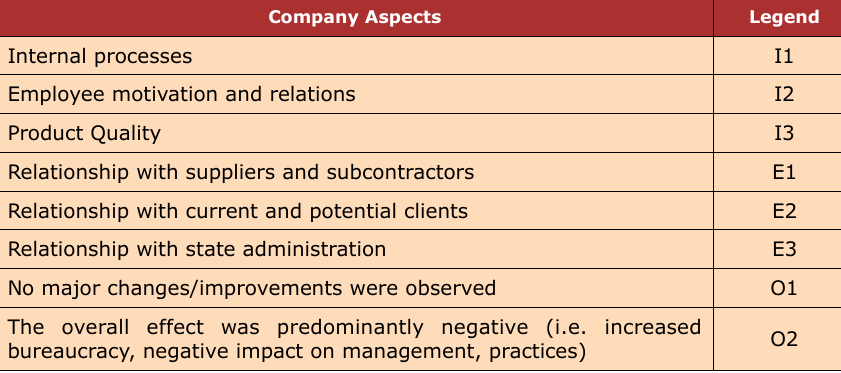
Figure 3. Impact of ISO 9001 on company